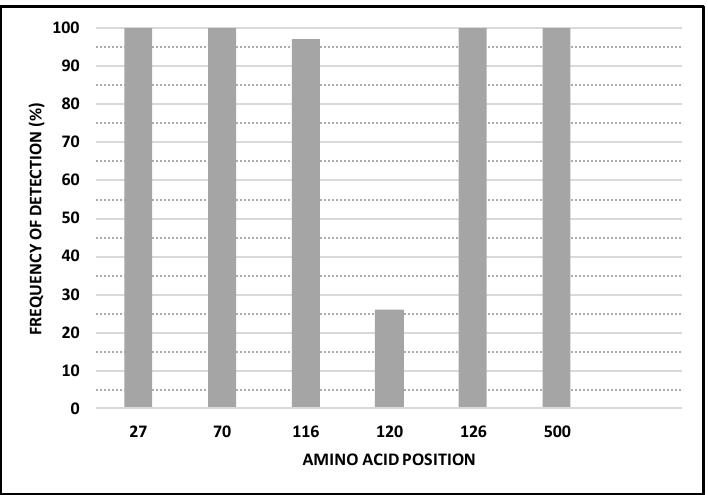
Figure 2. A graphic representation of N-glycosylation site positions across the South African RSV F protein sequences and the frequency of detection of NX(T/S)X sequons, 2019 to 2020.